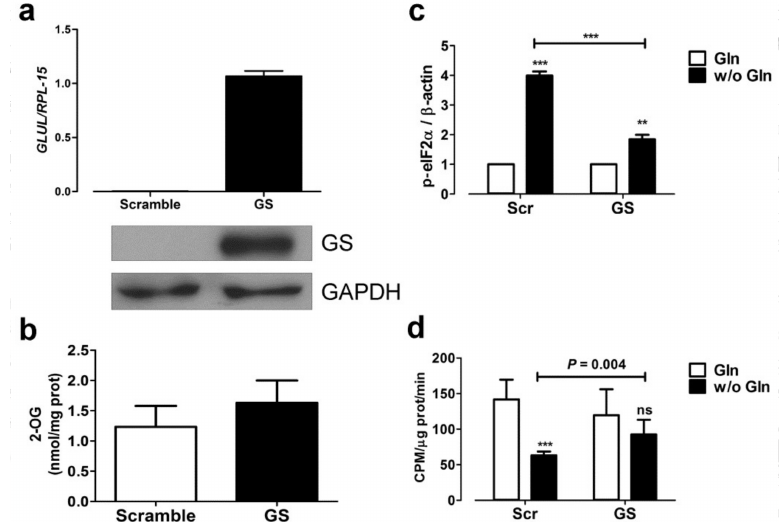
Figure 6. GS expression blunted eIF2 α phosphorylation and rescued protein synthesis in Gln-starved cells. ( a , b ) GLUL mRNA ( a , top ), GS protein ( a , bottom ), and 2-OG content ( b ) were assessed by real-time PCR ( a , top ), Western Blot ( a , bottom ) or LC-MS/MS ( b ) in Hs683 cells transfected with pCMV-GLUL vector (GS) or a scramble control (Scramble). PCR data were normalized to the expression of RPL-15 , and GAPDH was used for loading control for Western Blot. A representative experiment is shown. ( c , d ) Hs683 cells, transfected with the pCMV-GLUL vector (GS) or a scramble control (Scr), were incubated with or without Gln. ( c ) After 1 h, the expression of the phosphorylated form of eIF2 α was assessed. β -actin was used for loading control. The graph shows the relative expression (means ± SD) of p-eIF2 α obtained in three independent experiments. ** p < 0.01, *** p < 0.001, as assessed with two-tail student t test. ( d ) After 19 h, the rate of protein synthesis 0was assessed. Data are expressed as CPM/ µ g prot/min. Means ± SD of three experiments are shown. *** p < 0.001, as assessed with two-way ANOVA; ns, not